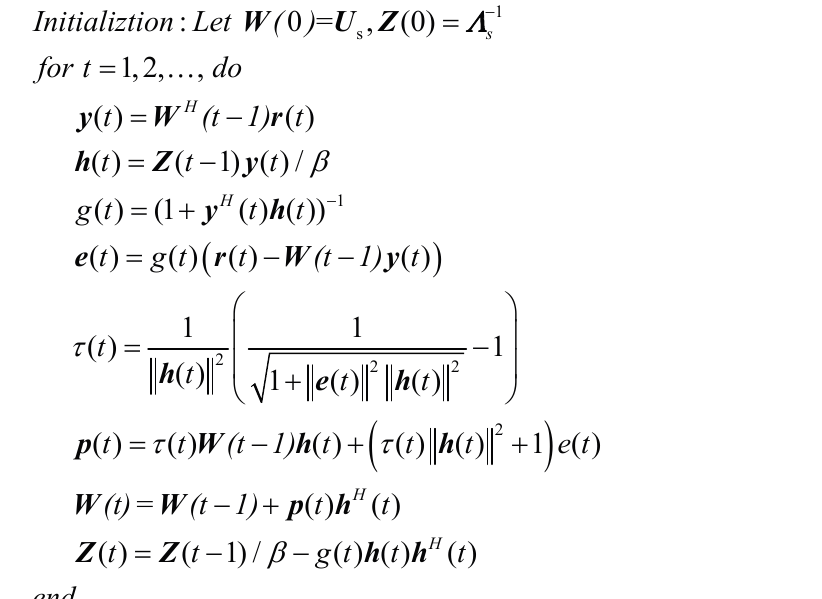
Algorithm 2. Orthogonal projection approximation subspace tracking (OPAST)